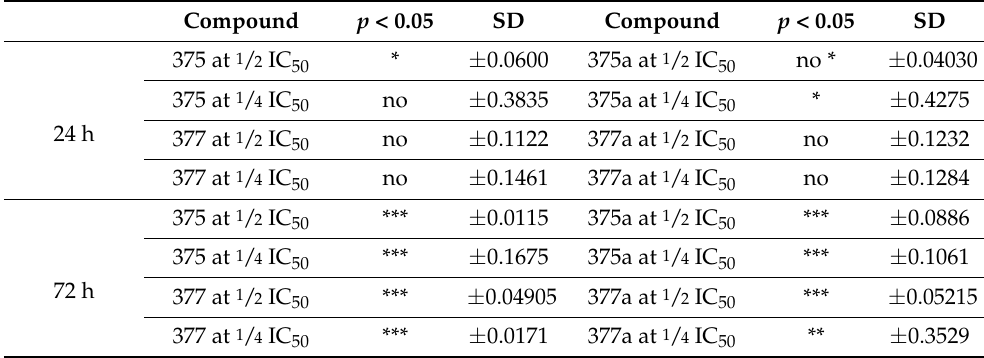
Table 4. Effect of 375 , 375a , 377 , and 377a at IC 50 , 1 / 2 IC 50 , and 1 / 4 IC 50 concentrations on HEC-1A cells proliferation. Results are presented for 24- and 72-h incubation periods. One-way ANOVA with Bonferroni’s comparison test was chosen for statistical